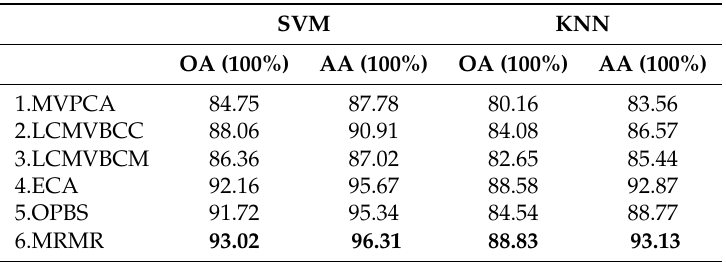
Table 5. Overall Classification Accuracies and Average Classification Accuracies of Using the Fifteen Bands Selected from the Salinas Dataset. (The bold denotes the best